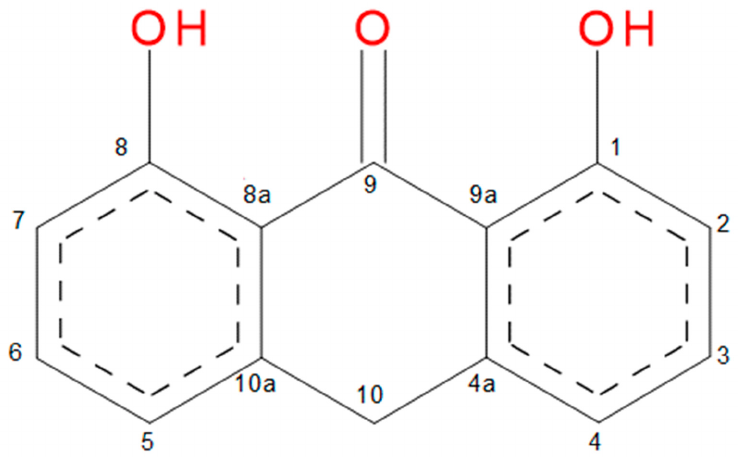
Scheme 1. Molecular structure and atom numbering of